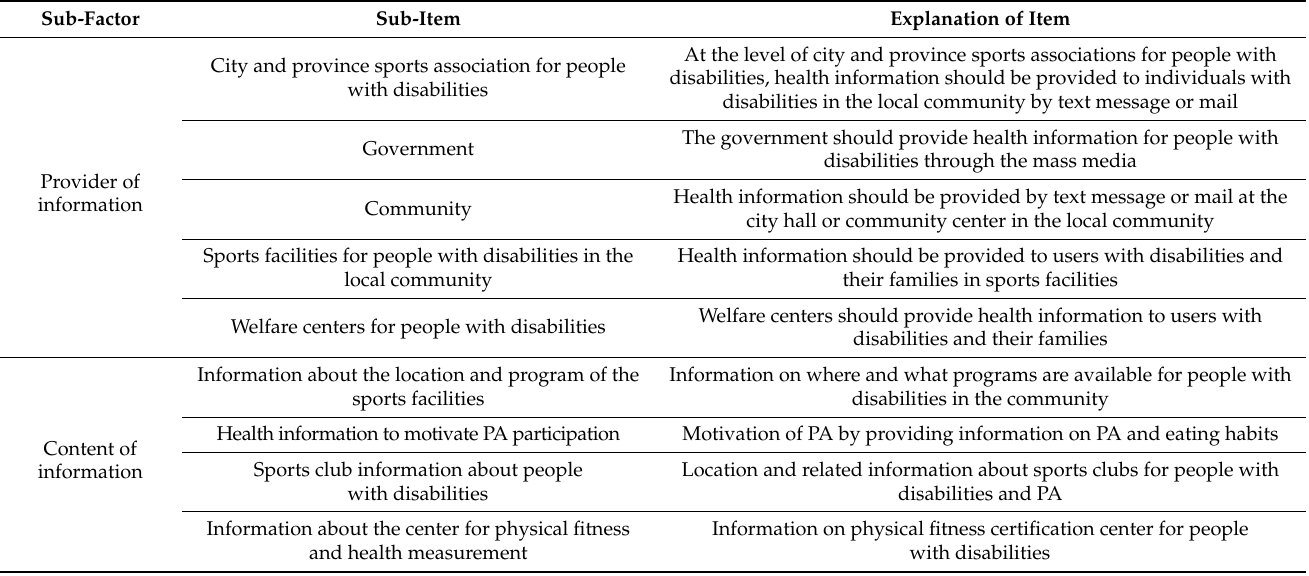
Table 14. Explanation of H4 by the information in